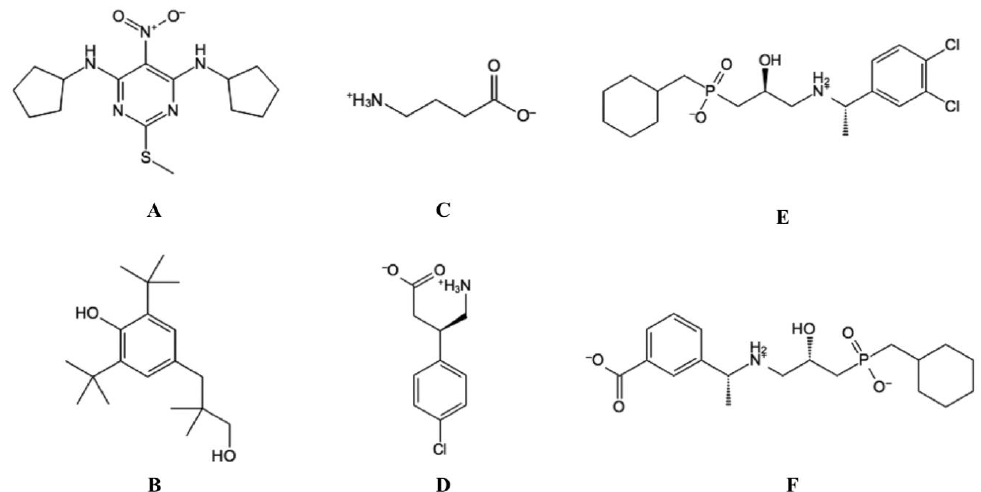
Figure 5. The structure of selected ligands targeting the GABA B -R. ( A ) GS39783, (PAM). ( B ) CGP7930, (ago-PAM). ( C ) GABA (endogenous agonist). ( D ) Baclofen (agonist), and ( E ) CGP54626 (antagonist). ( F ) CGP56999A (antagonist).